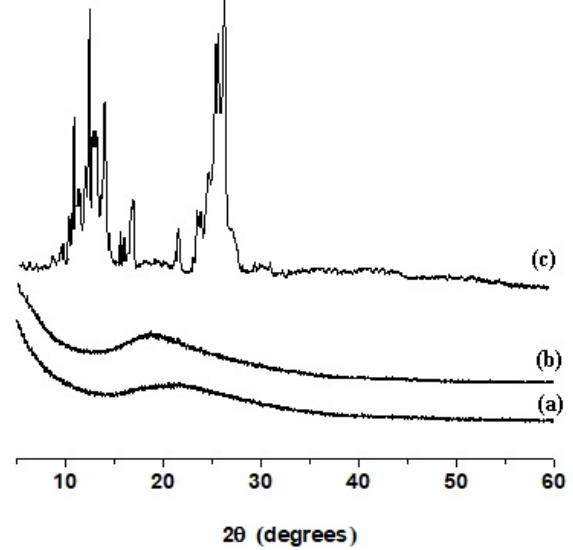
Figure 4. X-ray diffraction pattern of: (a) CA/PEG fibrous material, (b) CA/PEG/QUE fibrous material, and (c) QUE powder.